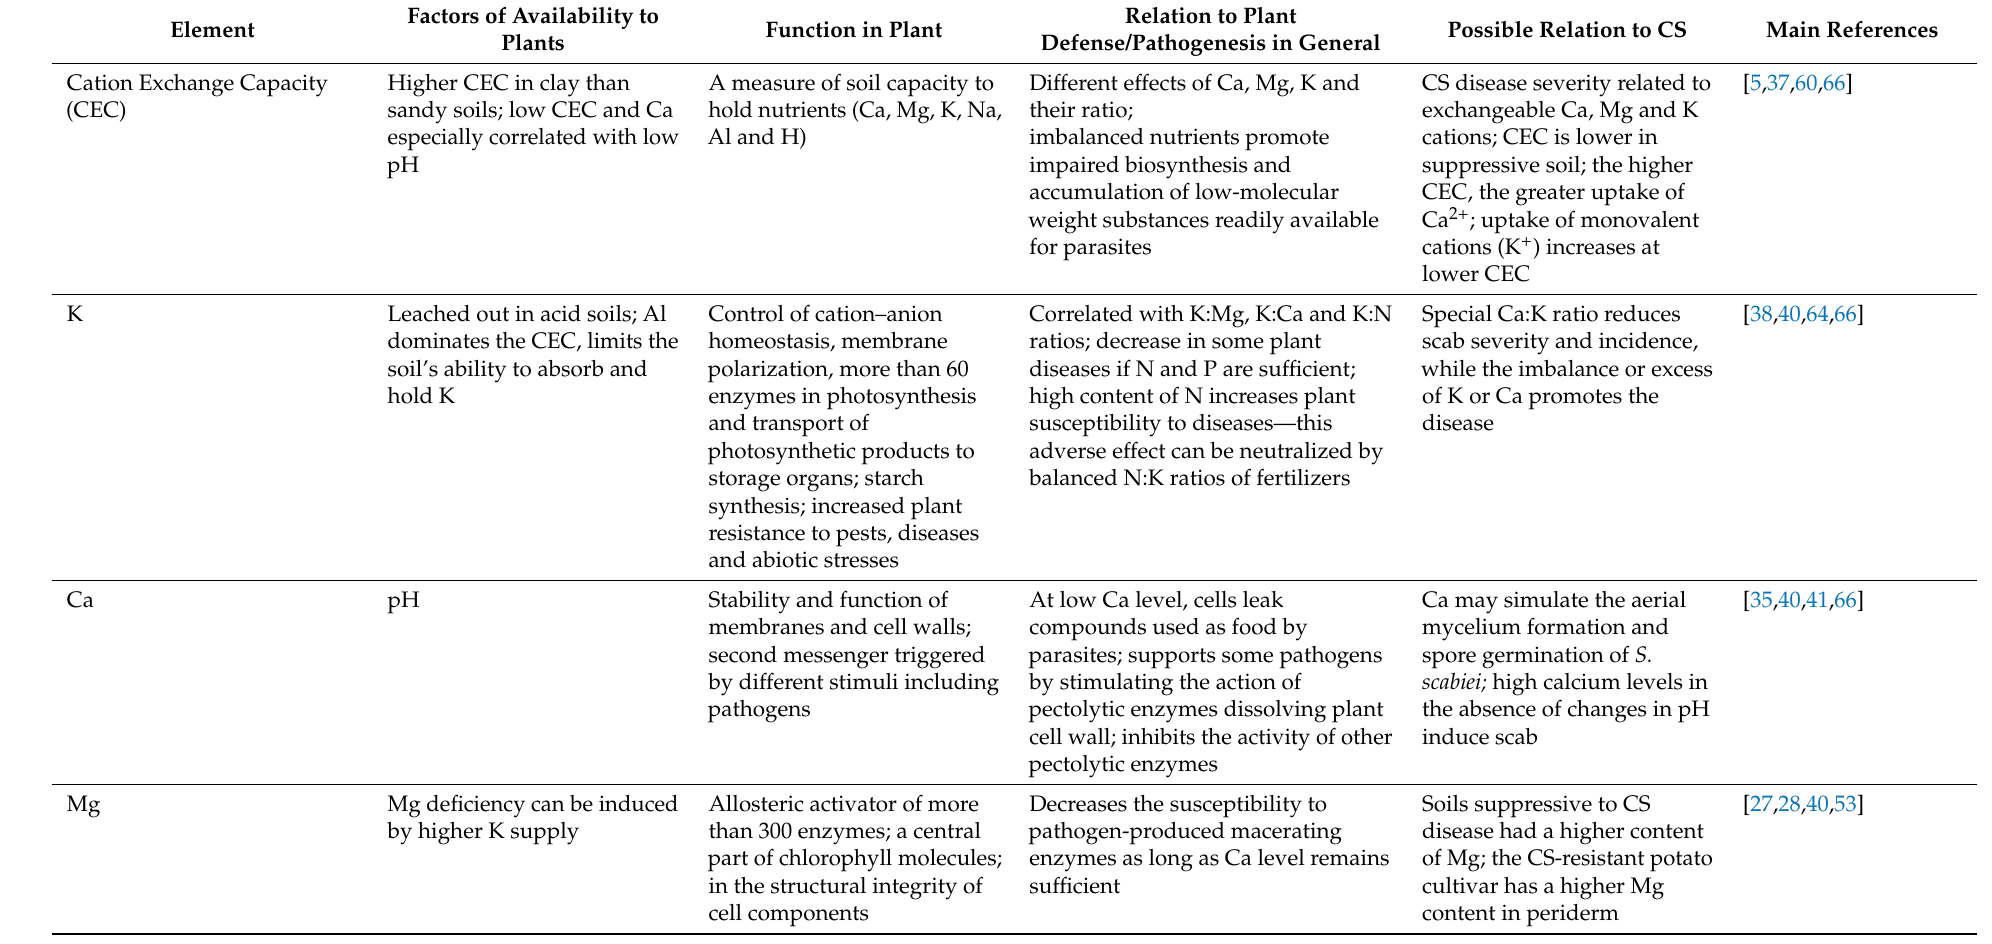
Table 1. Mineral nutrients availability in relation to common scab (CS)